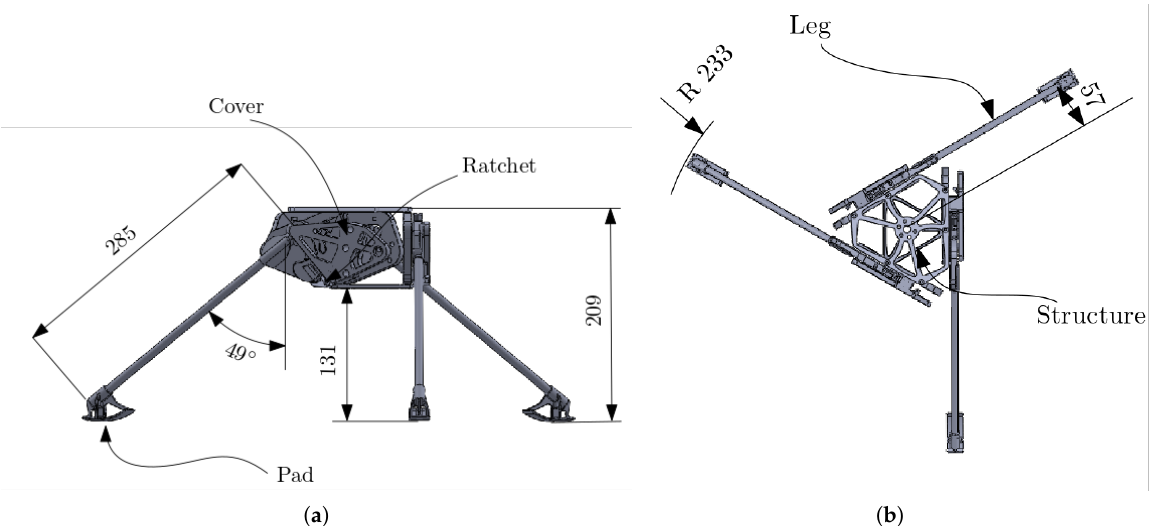
Figure 1. The computer-aided design (CAD) model of the proposed three-legged lander, along with labels for its main parts and main dimensions: ( a ) lateral view and ( b ) top view.